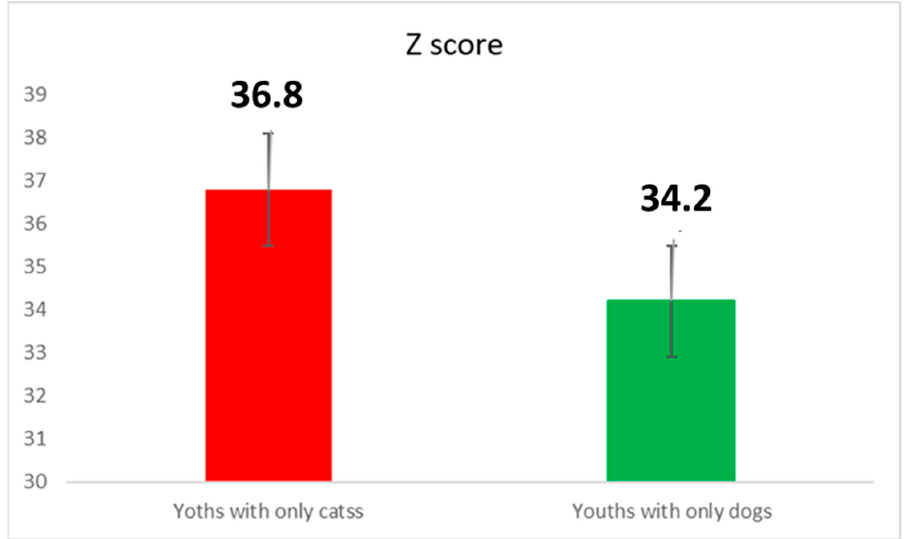
Figure 3. The Z score both for youth cat and dog owners.